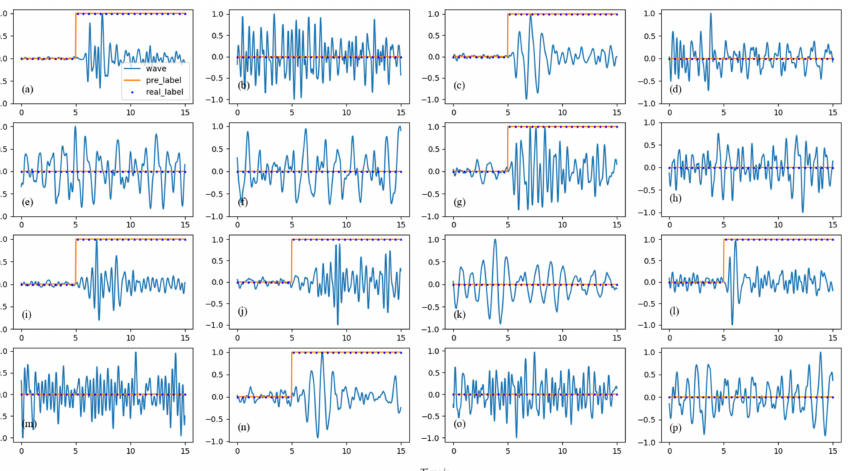
Figure 9. Signal prediction results of the test data set versus real results (In the a – p subfigure, the blue “ . . . ” denotes a real signal category,1 means seismic phase, 0 means noise signal; the yellow “—” denotes a model-predicted signal category. All the predicted results are consistent with actual results.).